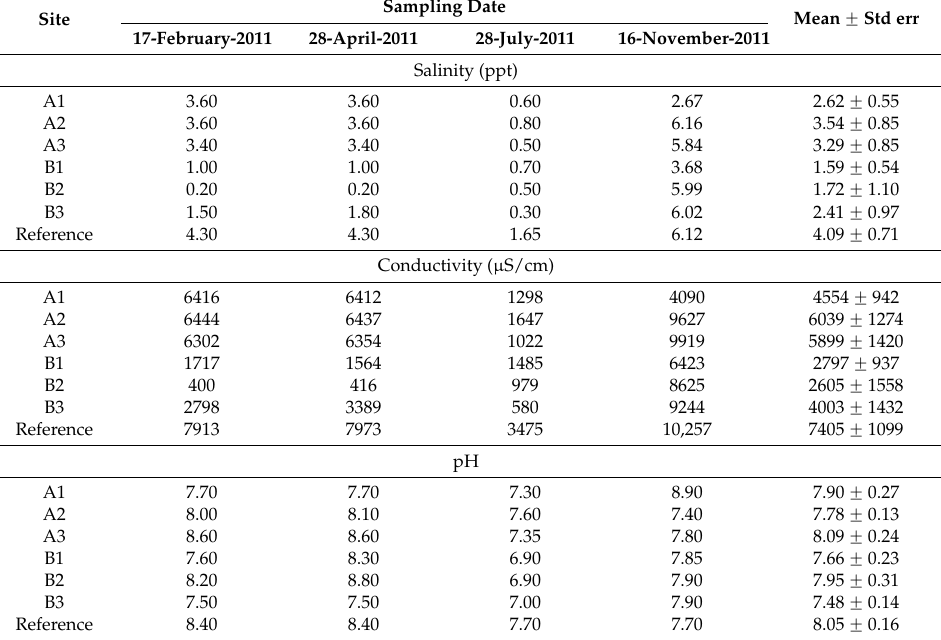
Table 1. Surface water salinity, conductivity, and pH measured at sampling sites in the CWU.